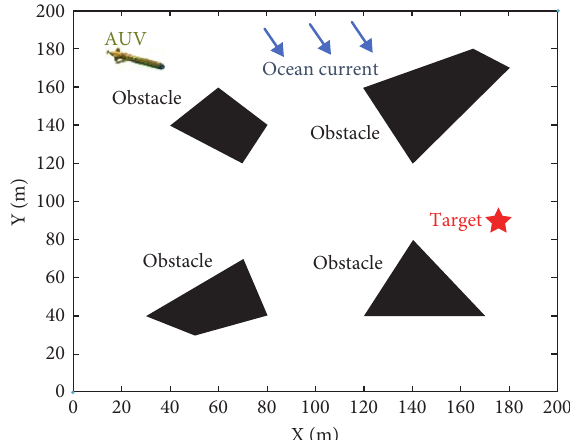
Figure 1: Complex marine